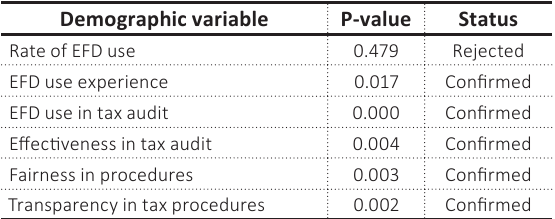
Table 5. Tax compliance and other variables –